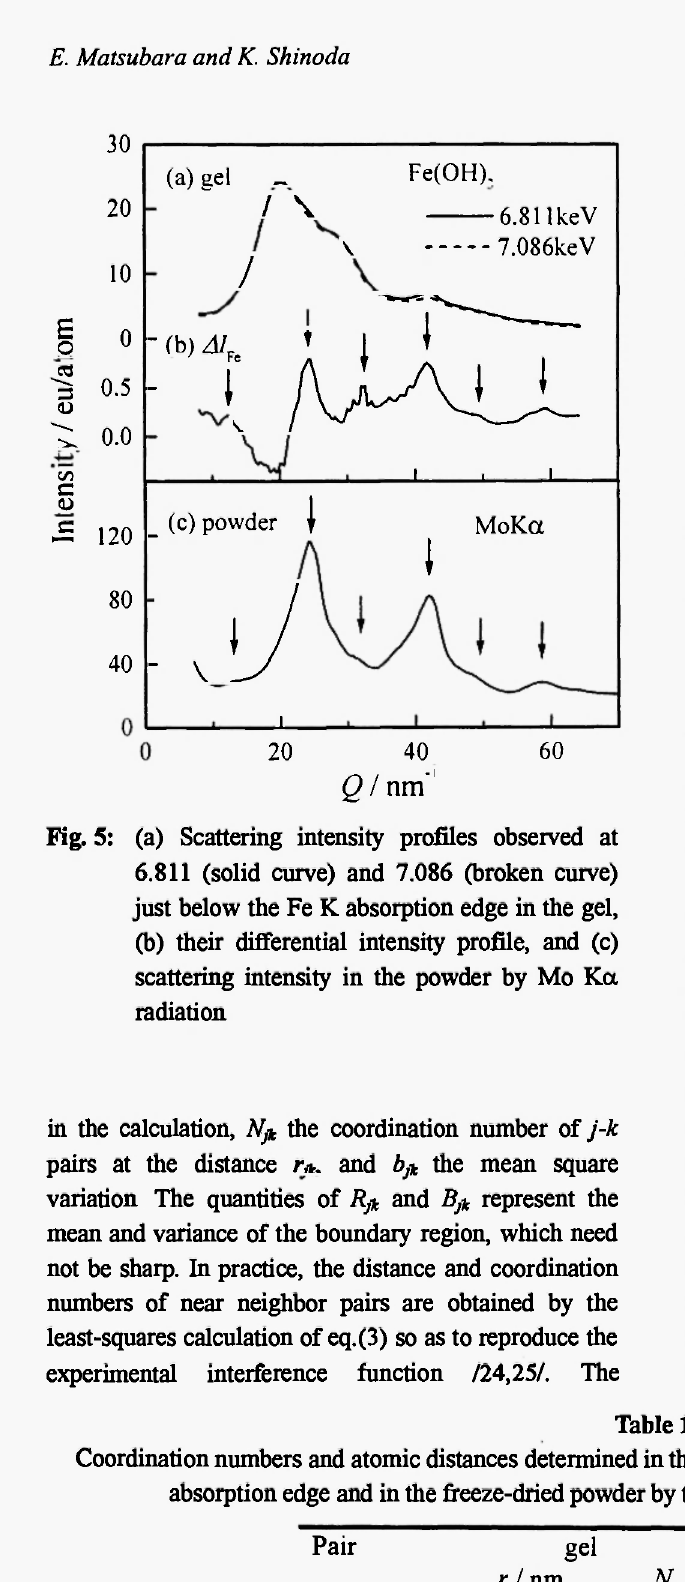
numbers of near neighbor pairs are obtained by the least-squares calculation of eq.(3) so as to reproduce the experimental Coordination numbers and atomic distances determined in the ferric hydroxide gel by the AXS method at the Fe Κ absorption edge and in the freeze-dried powder by the conventional x-ray diffraction method /8/